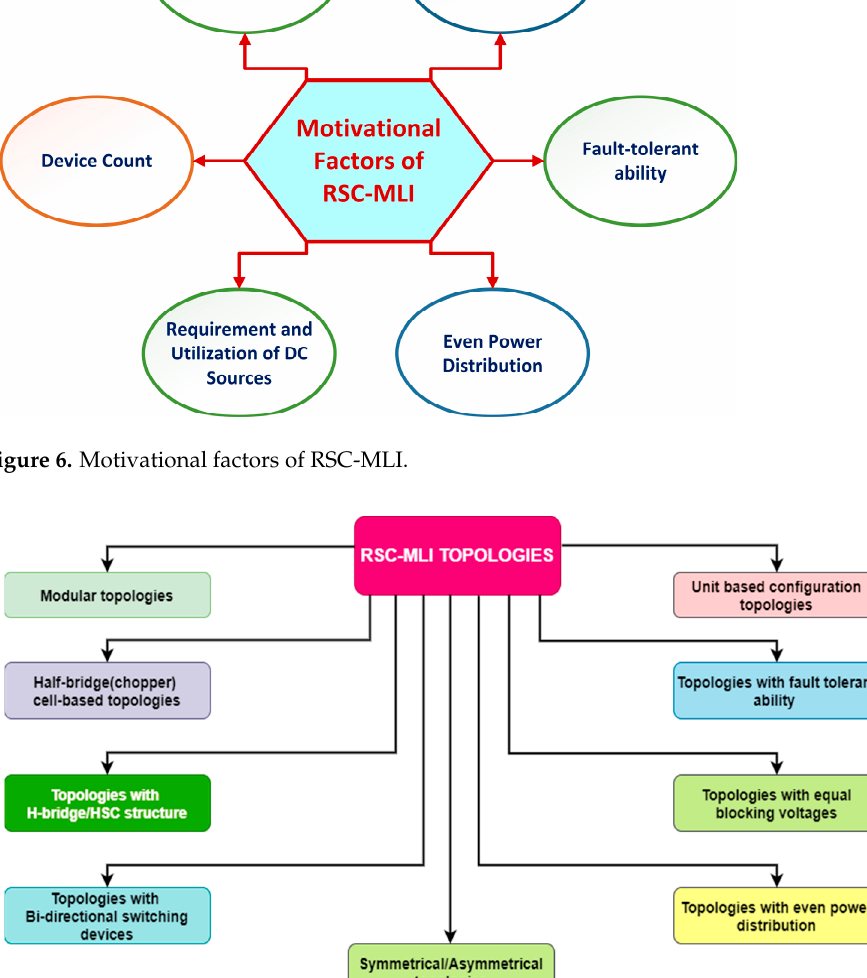
Figure 8. Assessment parameters of MLI.